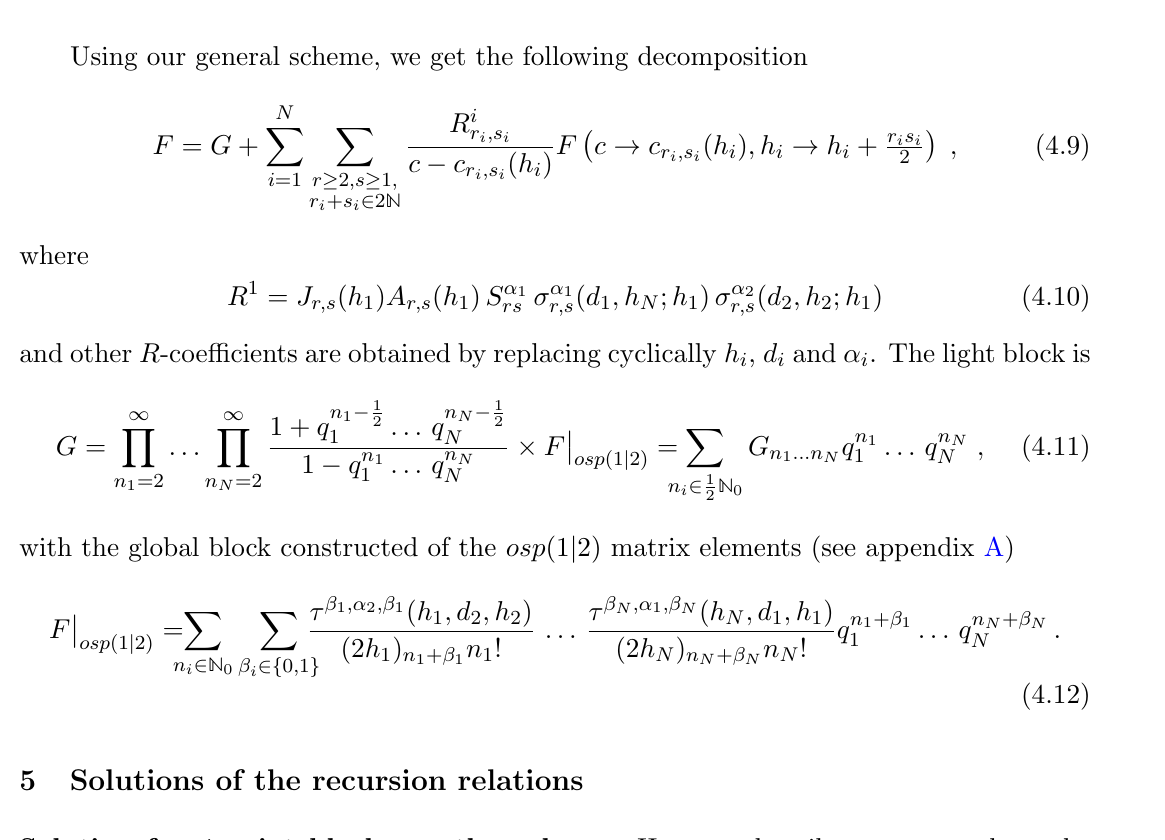
Figure 6 . Torus N -point conformal block in the necklace